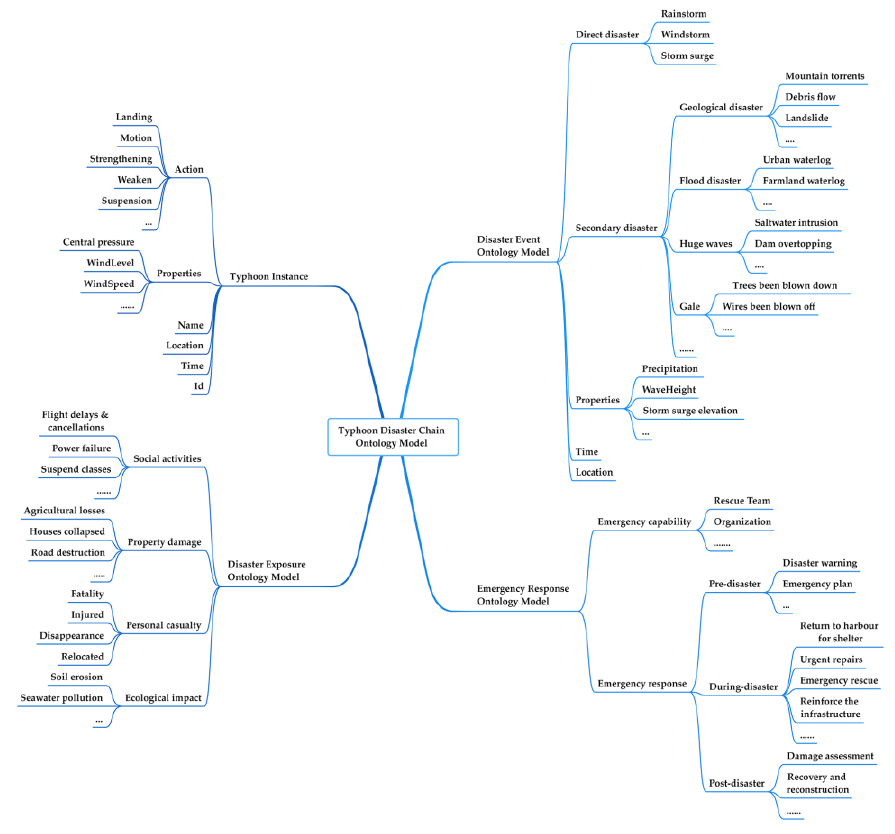
Figure 2. The conceptual framework of typhoon disaster chain ontology.